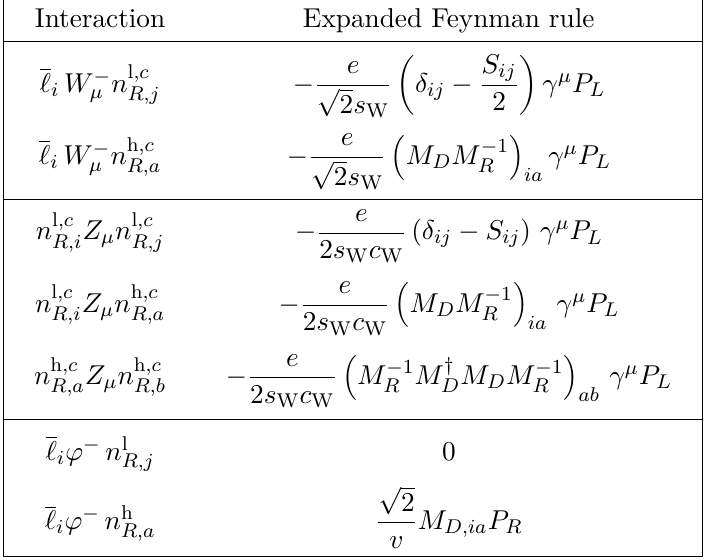
Table 1. Feynman rules at leading order in the seesaw expansion, neglecting charged lepton masses. The active (light) states are denoted as n l , the sterile (heavy) states as n h . M mass matrix defined in eq. (2.3), M is the n × n real and diagonal Majorana mass matrix introduced R in eq. (2.1) and S the mass insertion defined in eq. ij